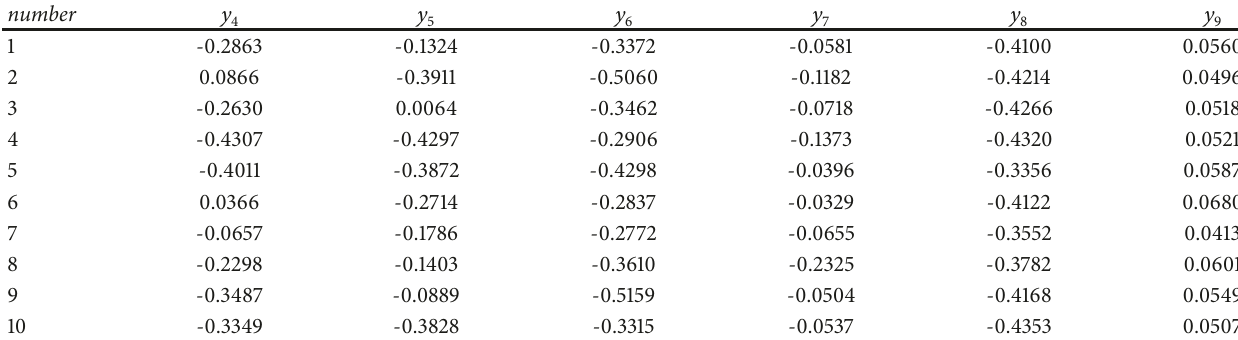
Table 6: The category feature of multiwavelet entropy of the mild drought stress group.